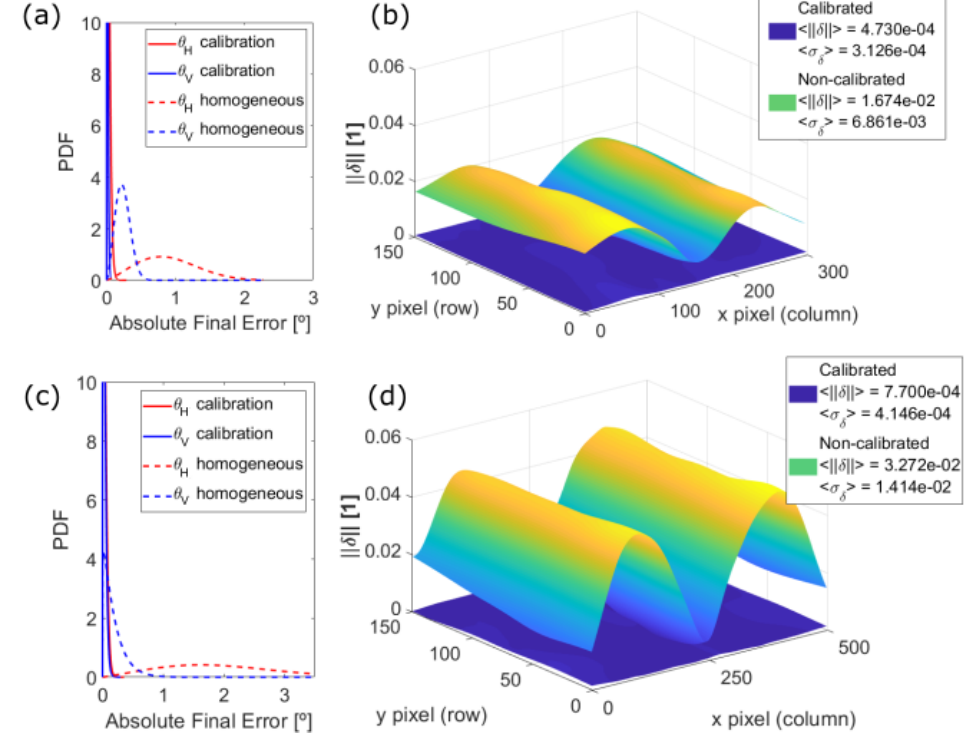
Figure 14. Improvement of the presented calibration for ( a , b ) the 30 × 20 ◦ and ( c , d ) the 50 × 20 ◦ FOV prototype, compared to their respective ideal cases of homogeneous angular resolution. ( a , c ) Probability density functions of the angular error, being ( red ) the horizontal and ( blue ) the vertical scanning direction of ( dashed line ) the non-calibrated and ( solid line ) the calibrated case. ( b , d ) Norm of the final point distance